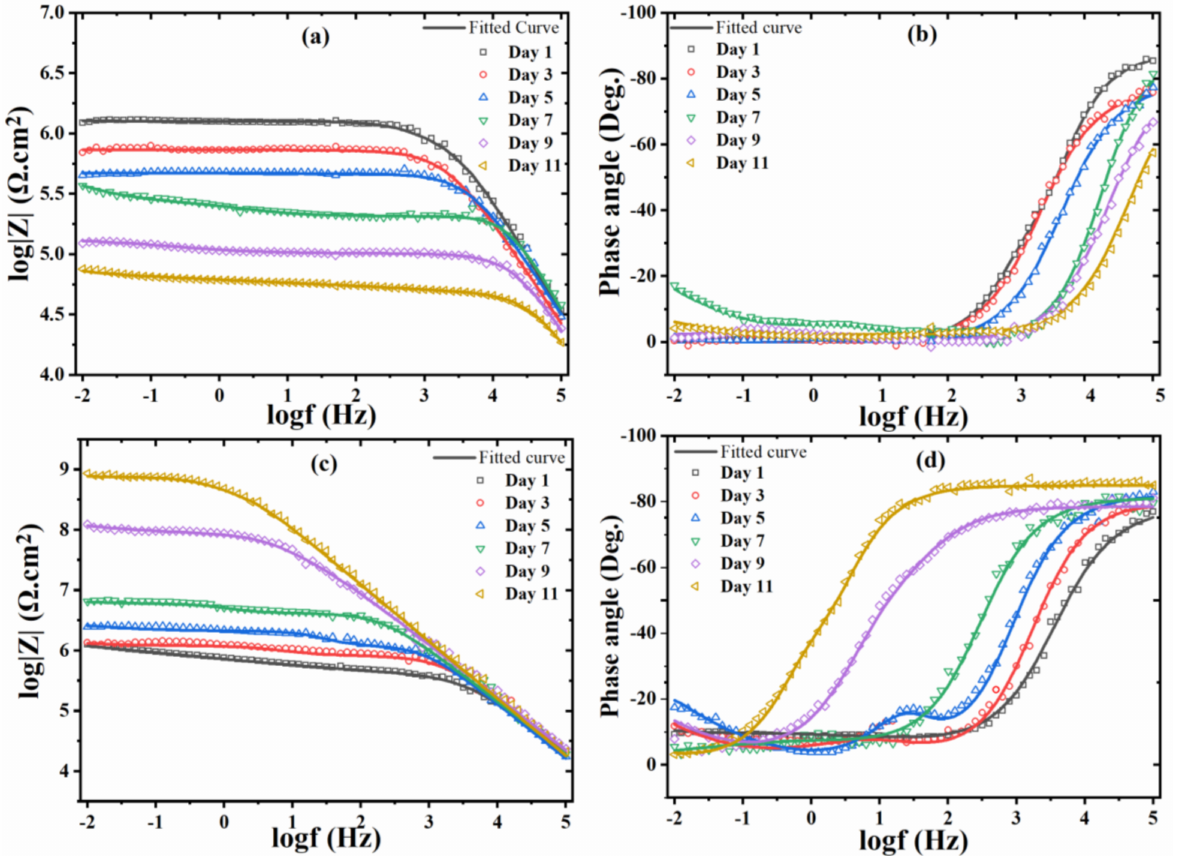
Figure 6. EIS Bode plots of ( a , b ) reference coating and ( c , d ) Y 2 O 3 /IMD modified